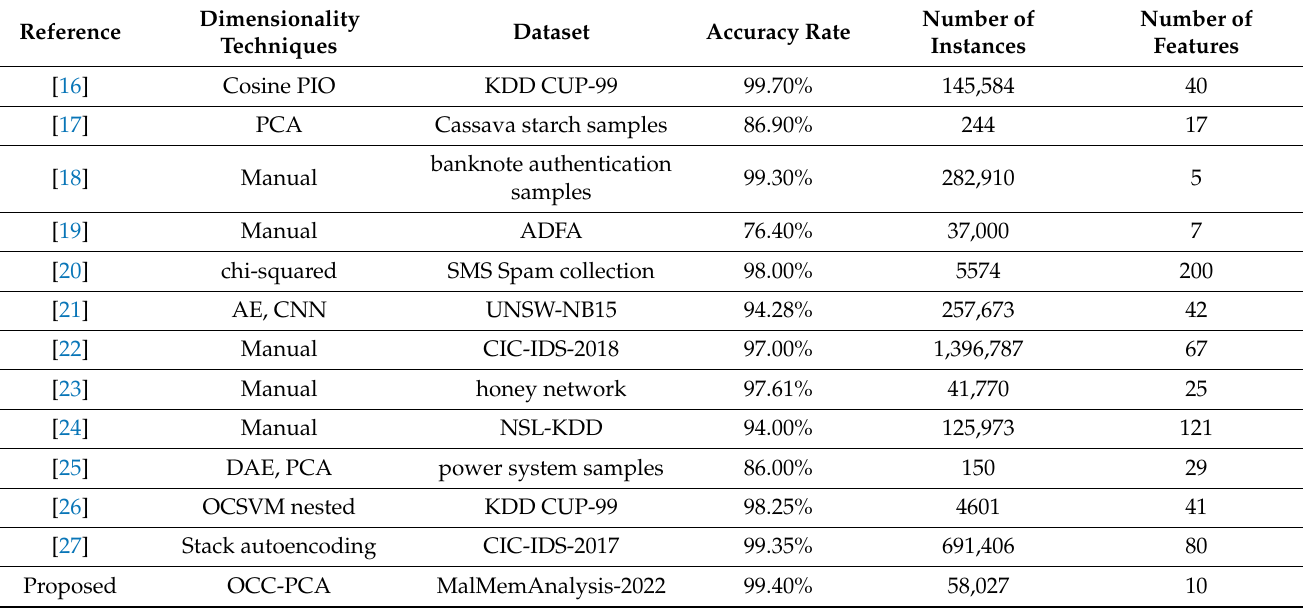
Table 1. A Comparison of the Proposed Approach with other Existing OCSVM-Based